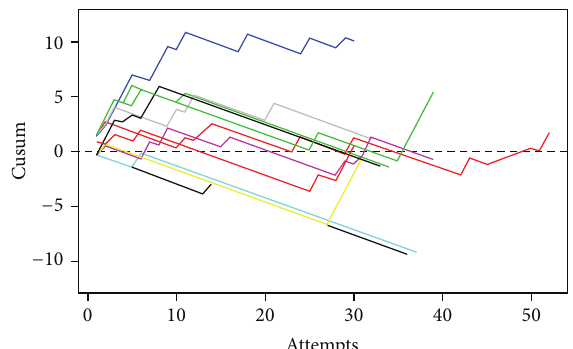
Figure 2: Orotracheal intubation cumulative hazard curve for number of attempts to cross ℎ 0 with 20% acceptable failure rate.